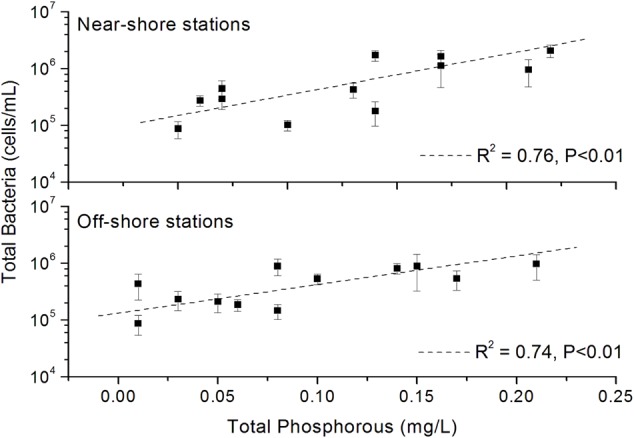
Significant (p < 0.01) correlation between total bacterial abundance and total phosphorous. Values on Y-axis are shown in log-scale.